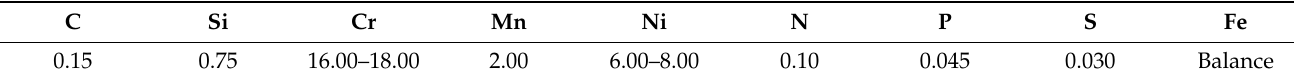
Table 1. Chemical compositions of SUS301 (wt%).